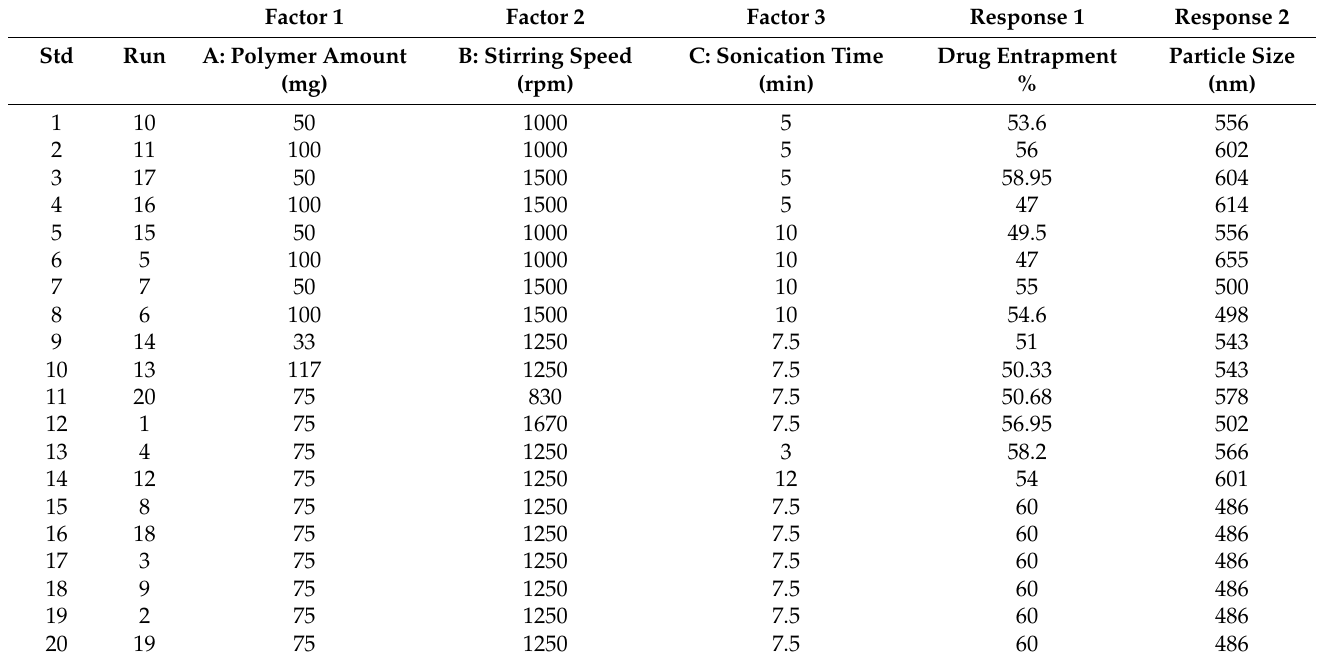
Table 1. Design table for optimized batch formulation.